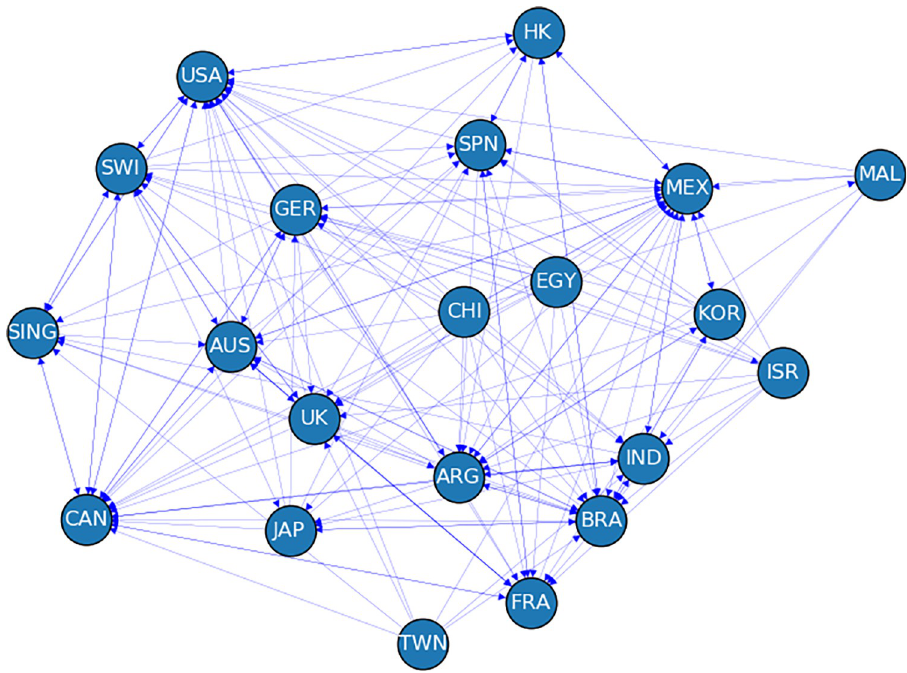
Fig 3. The global financial network of influence is constructed by the mean threshold during the global financial crisis (2008). Unequal influences are observed among the indices. American indices influence more than other indices. Full forms of node labels are given in the S1